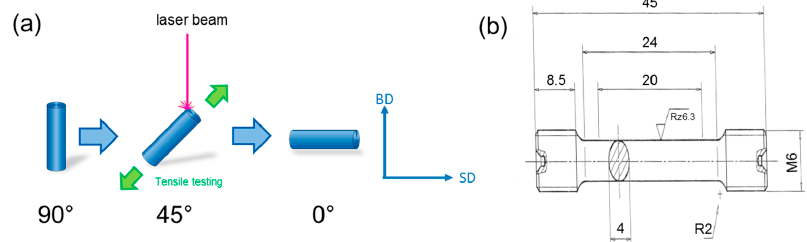
Figure 2. ( a ) Schematic illustration of the build-up process of the cylindrical billets for tensile specimens. The angles denote the position of the tensile direction with respect to the scan direction (SD). BD denotes the build-up direction; ( b ) Geometry (in mm) of the tensile samples used for mechanical testing (DIN 50125).